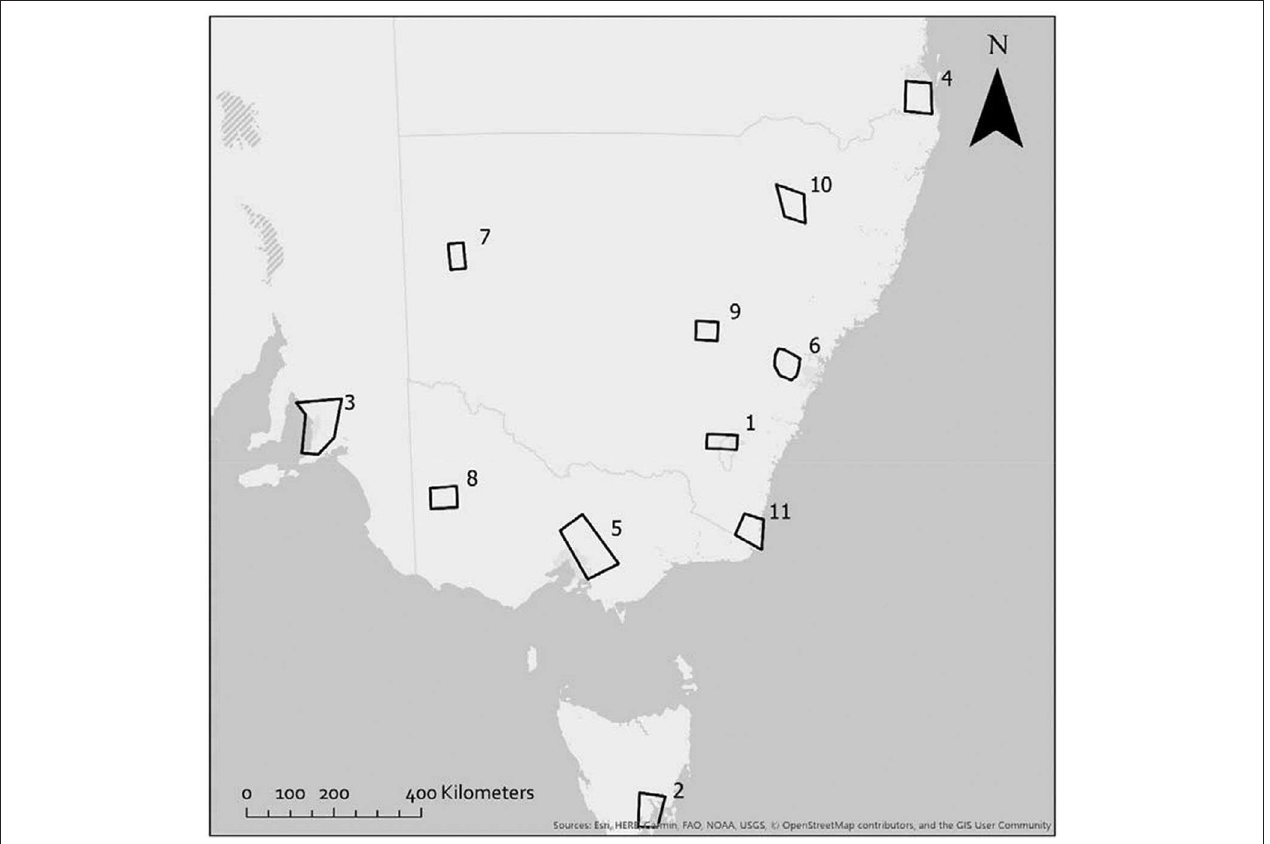
FIGURE 1 | Case study locations in south-eastern Australia. 1, ACT Canberra; 2, TAS Hobart; 3, SA Adelaide Hills; 4, South-eastern Queensland; 5, VIC Central Highlands; 6, NSW Blue Mountains; 7, NSW Broken Hill; 8, VIC Little Desert; 9, NSW SW Slopes; 10, NSW Nandewar; 11, NSW south-east